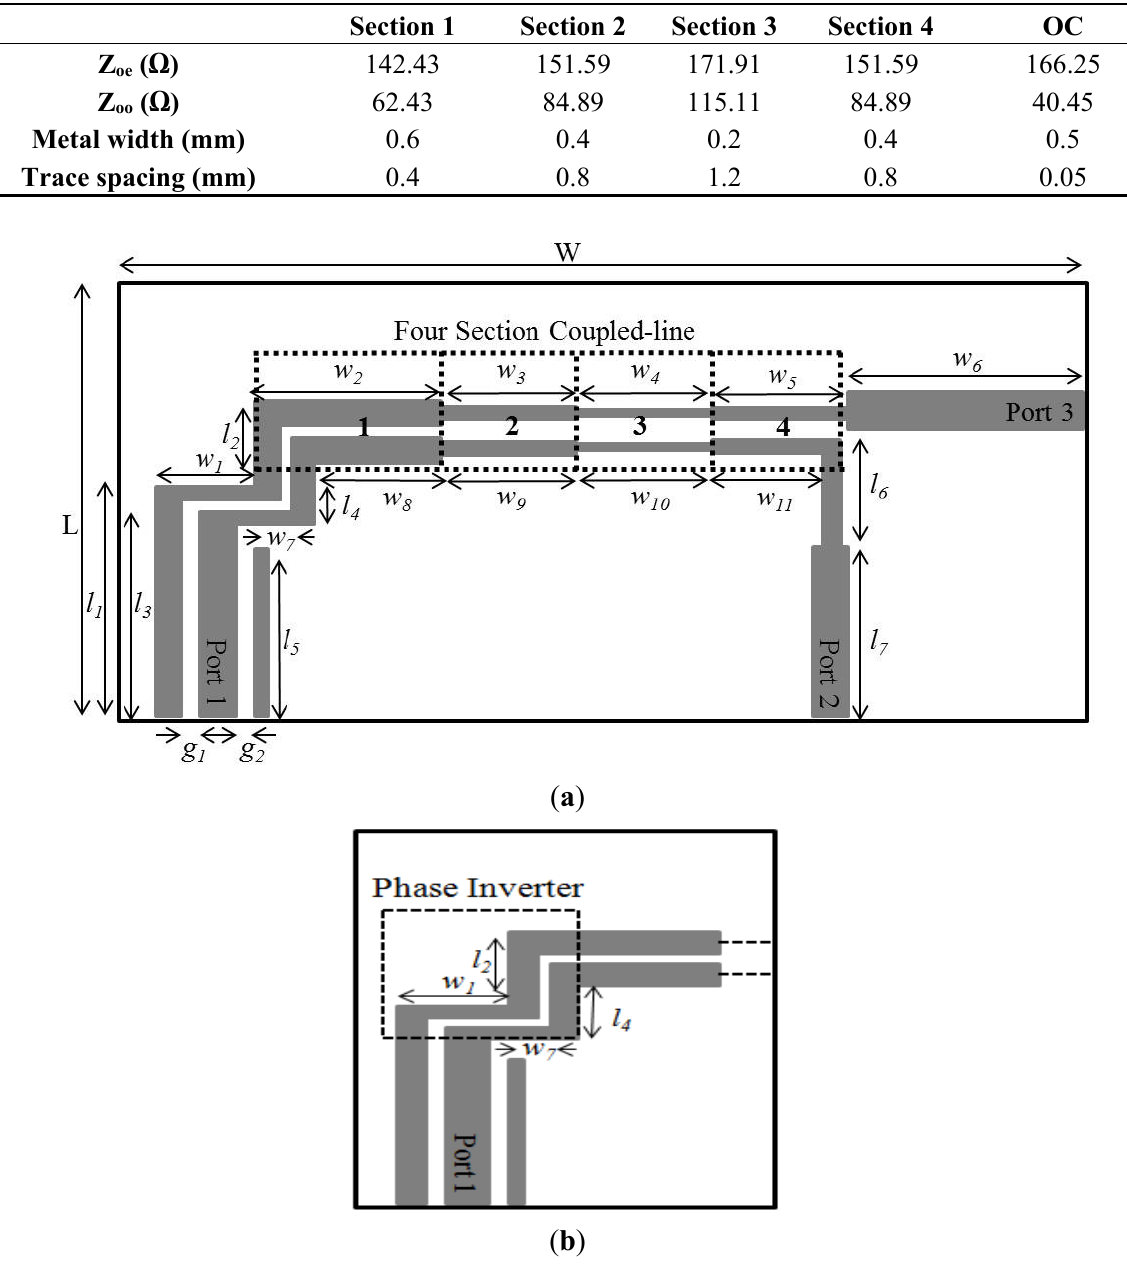
Figure 3. ( a ) Layout of the proposed balun in mm. ( w 1 = 10.2, w 2 = 9.7, w 3 =